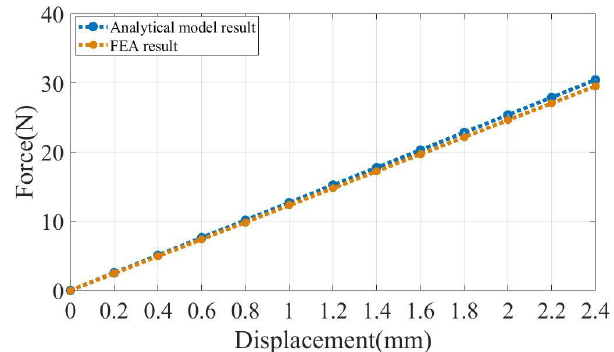
Figure 4. Relationship between the reaction force and displacement of the positive stiffness struc- ture.